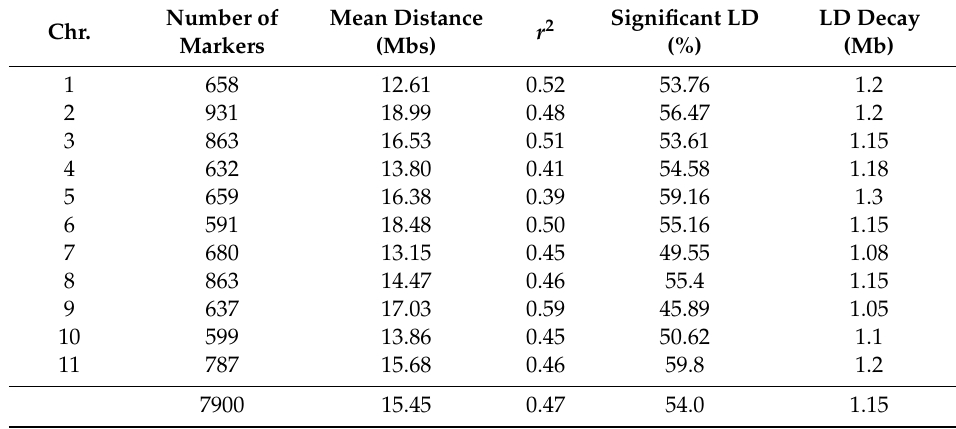
Chr. Table 3. Distribution and linkage disequilibrium of DArTseq markers on di ff erent chromosome of common bean.